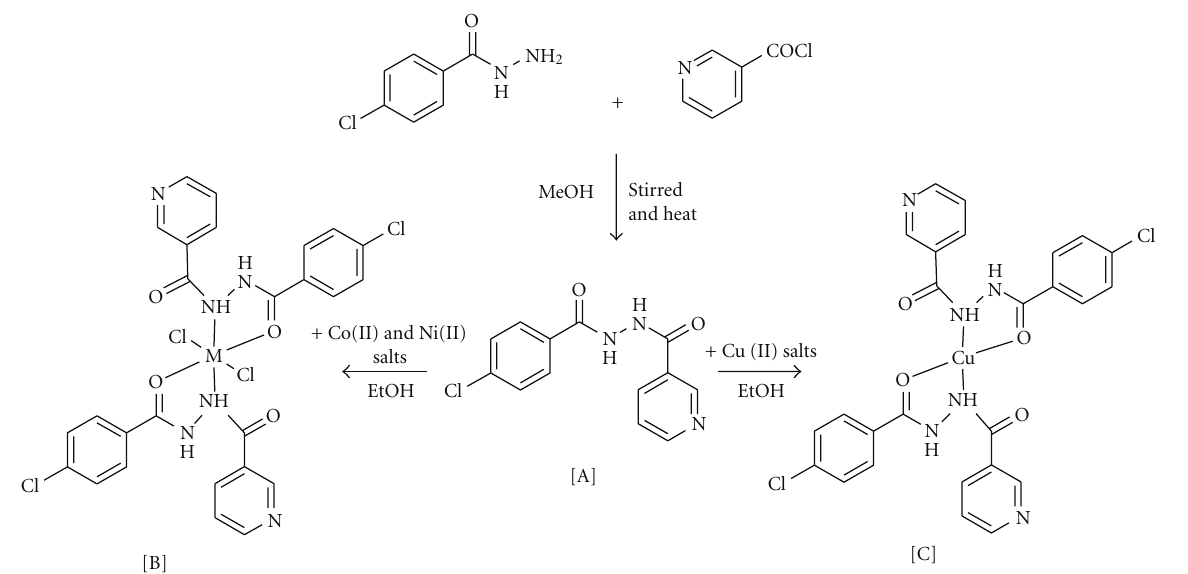
Scheme 1: Synthesis of ligand (HL) and its metal